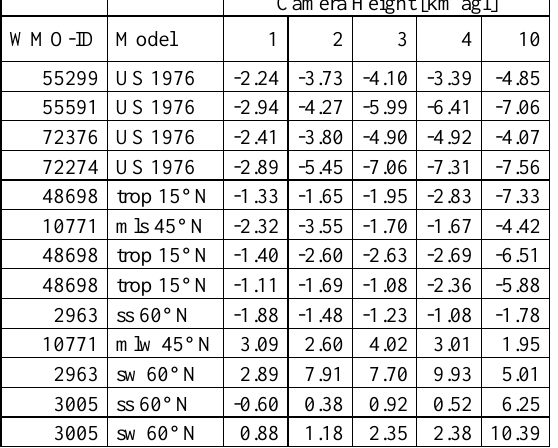
Table 4. Difference of the atmospheric refraction [ μ rad] between Eqn (5) and Eqn (9) for different camera height and for all sites. The difference is largest at 10 km camera